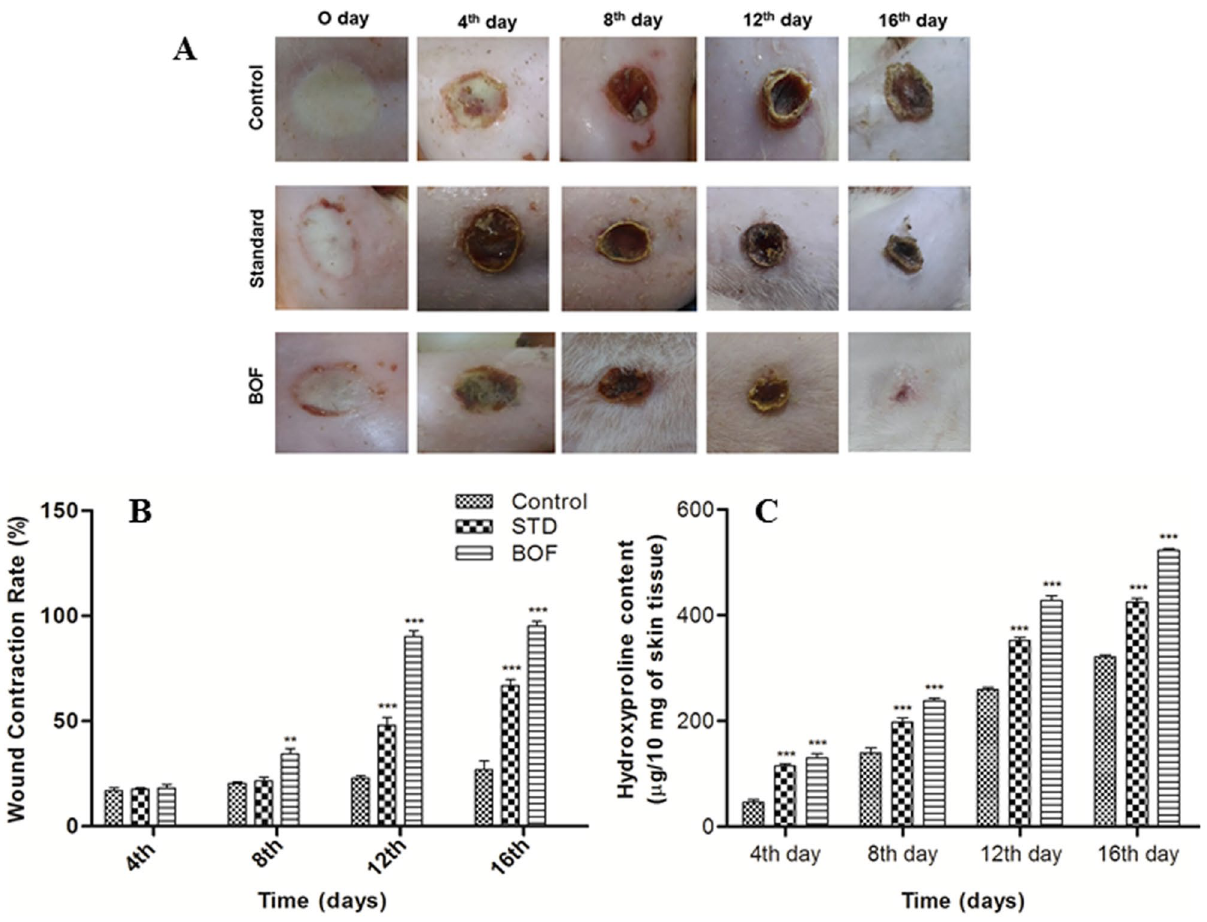
Figure 1. ( A ) Pictorial representation of rat skin after burn injury. ( B ) Comparative efficacy of different formulations on partial thickness burn wound healing in Wistar rats. ( C ) Hydroxyproline content of different treated